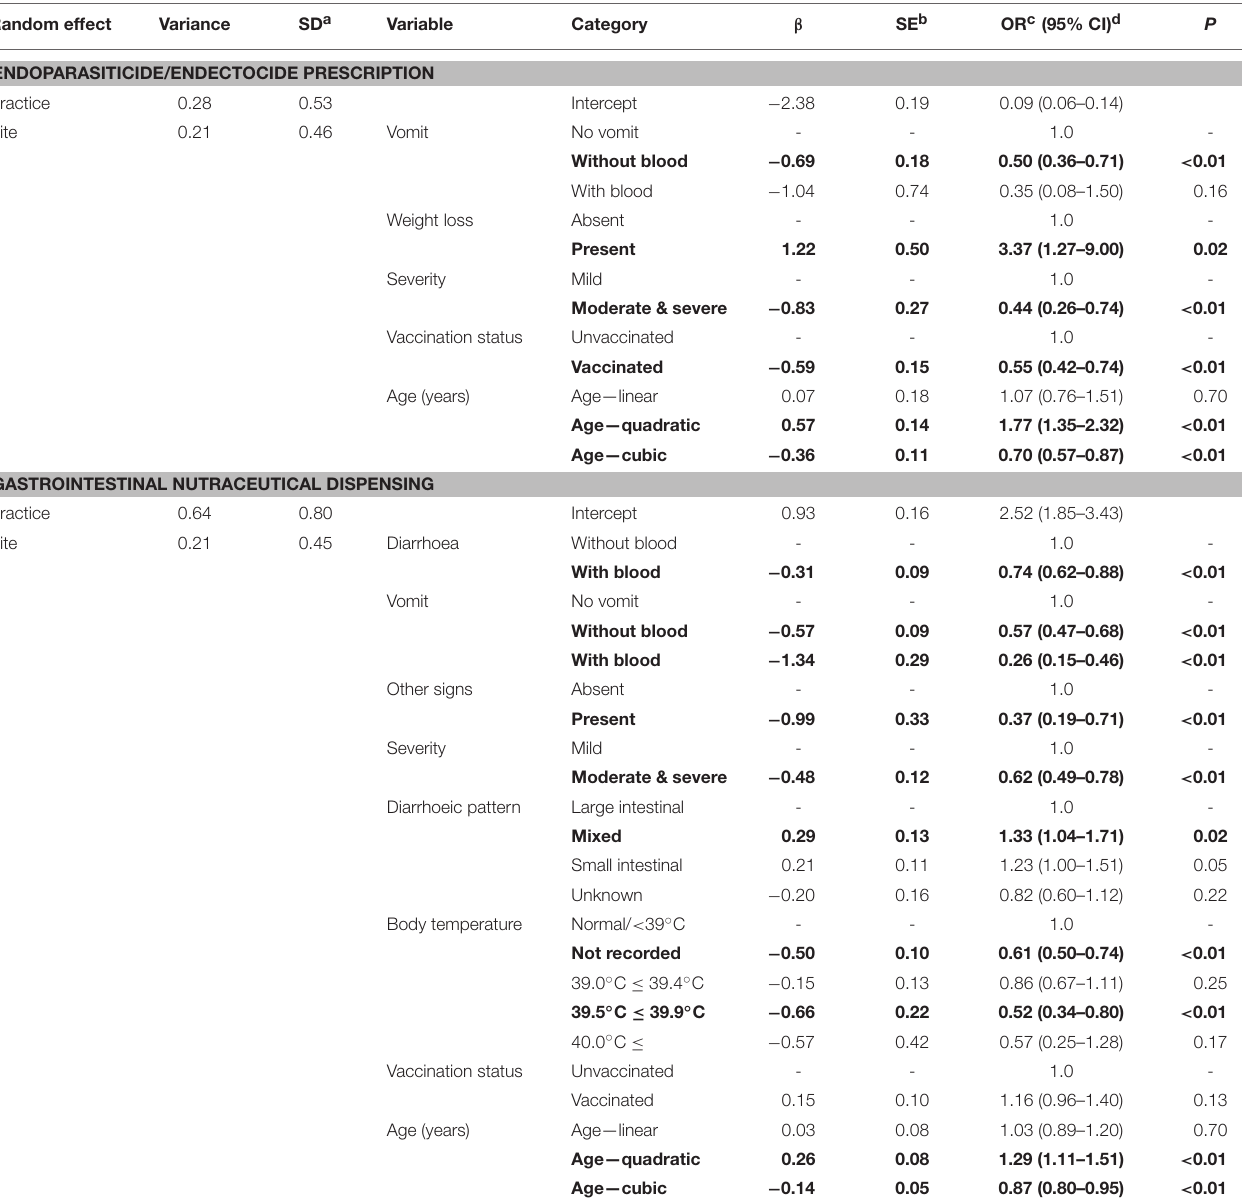
TABLE 6 | Parameter estimates from a finalised mixed effects logistic regression model, modelling on a case-level the presence of endoparasiticide/endectocide prescription and dispensing of gastrointestinal nutraceuticals against a range of risk factors. Random